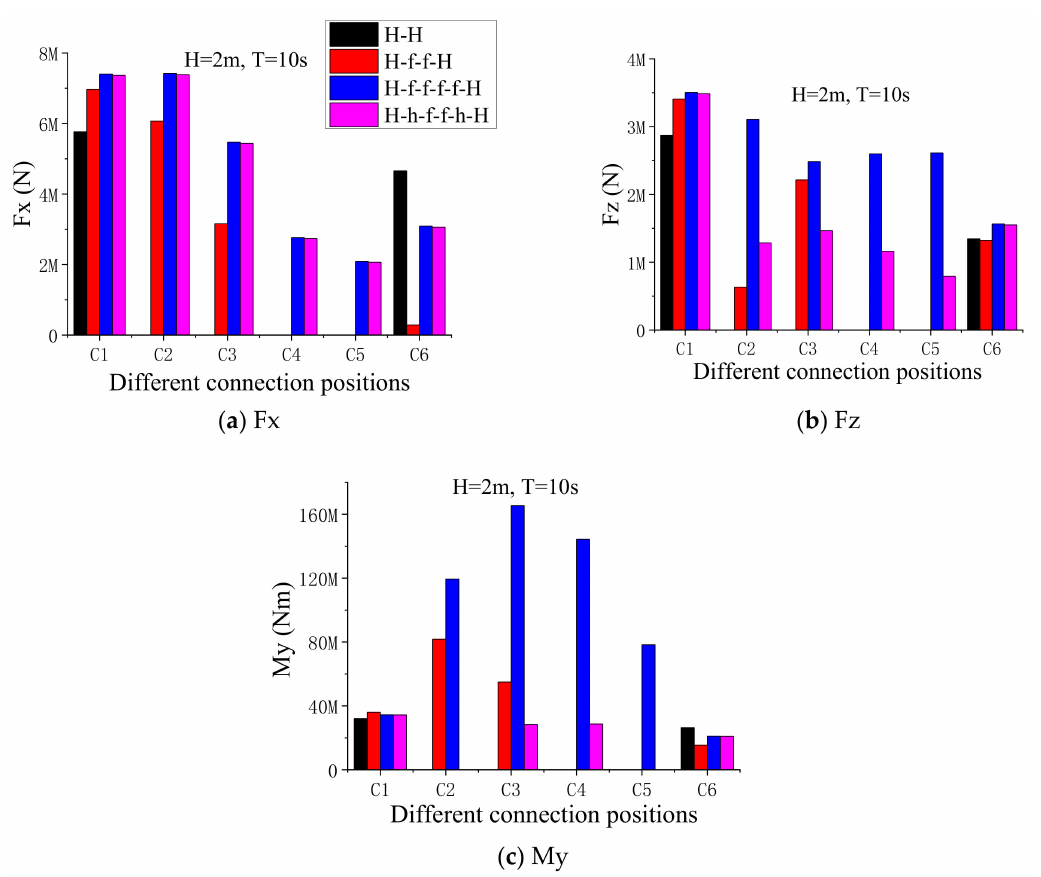
Figure 12. Comparison of main connectors’ loads of the MTLPW system with different number of inner TLP modules: ( a ) Fx, ( b ) Fz, ( c )